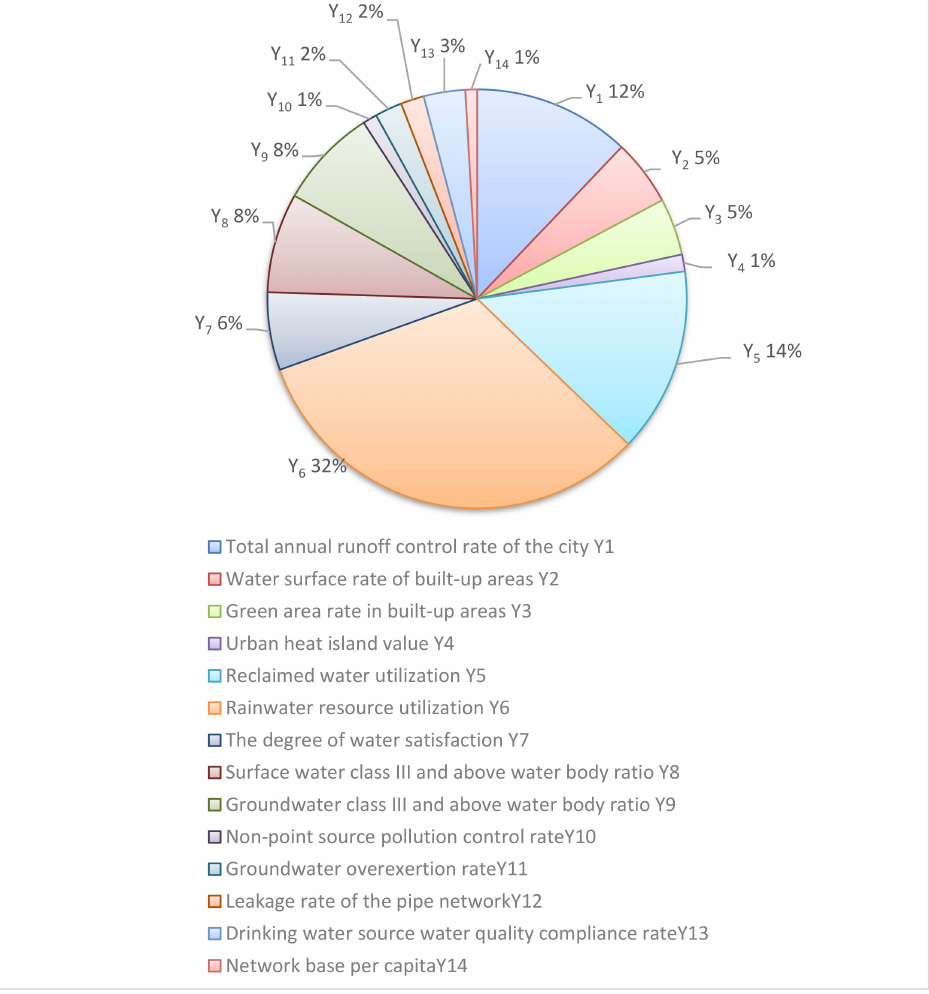
Figure 7. Water resilience evaluation model of Wuhan